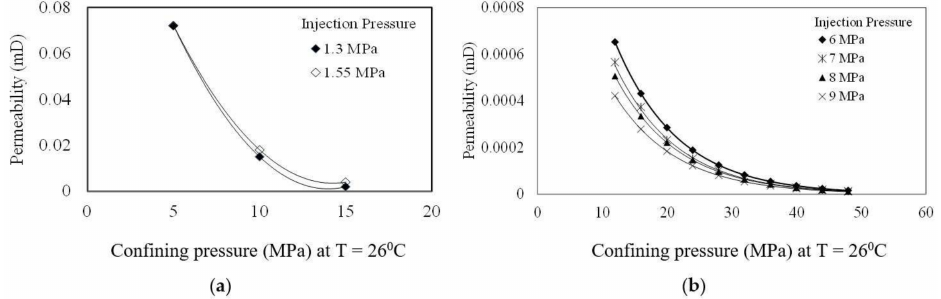
Figure 7. Influence of confining stress on CO 2 permeability in ( a ) Indian [40], and, ( b ) Australian [48] bituminous